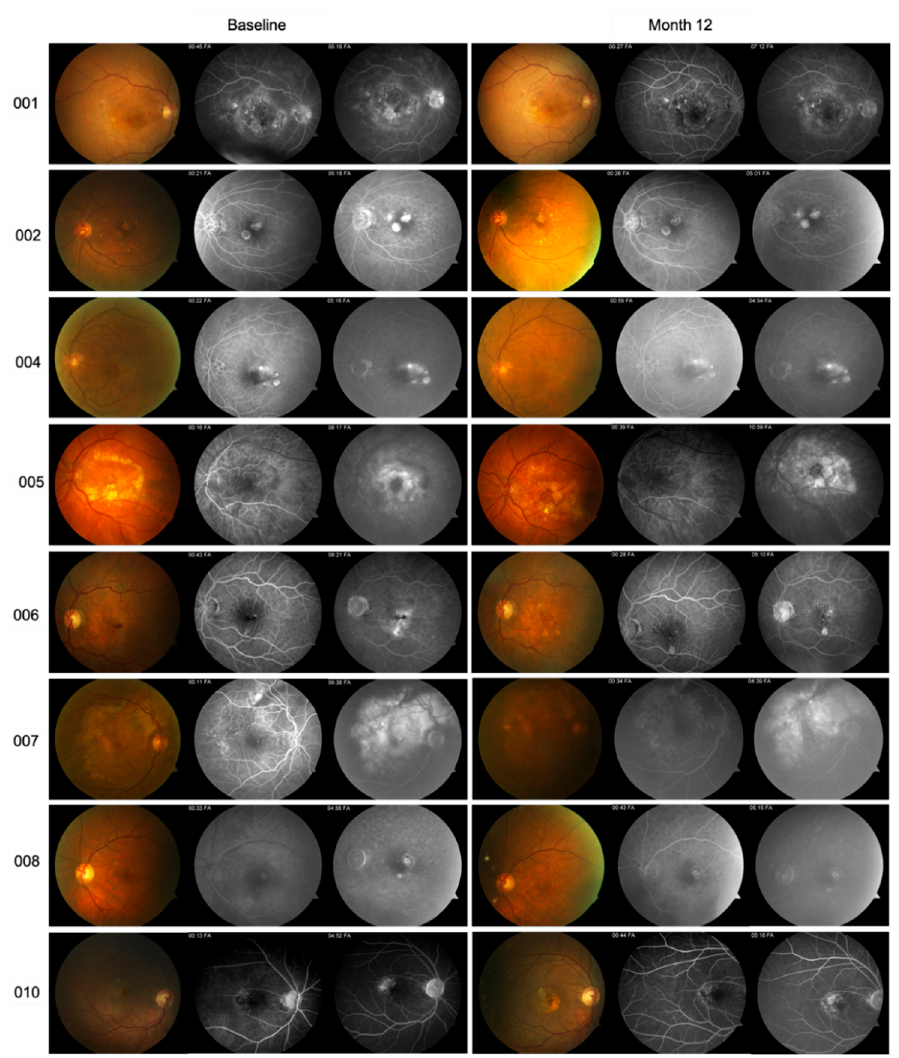
Figure 3. Representative images of fundus photography and fluorescein angiography at baseline and month 12 for subjects included in the RBZ-TALF group. All patients showed a decrease in active neovascularization activity.